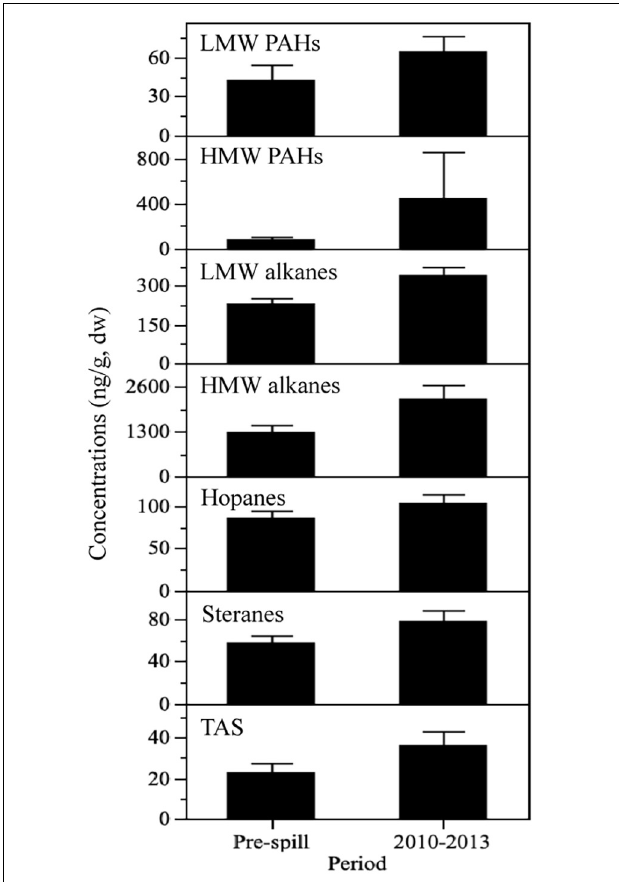
FIGURE 5 | Hydrocarbon concentrations (ng/g, dw) by periods from contaminated sediment samples collected in 2018 in the nGoM. Post-pill denotes the buried sediment layer deposited in 2010–2013, and pre-spill indicate concentrations in downcore layers deposited before 2010. LMW PAHs: 2–3 rings, HMW PAHs: 4–6 rings, LMW alkanes: C12–C23 n -alkanes, HMW alkanes: C24–C37 n -alkanes, hopanes: C23–C35, steranes: C27–C29, and TAS: C20–C28. Data shown as mean ± 95% confidence